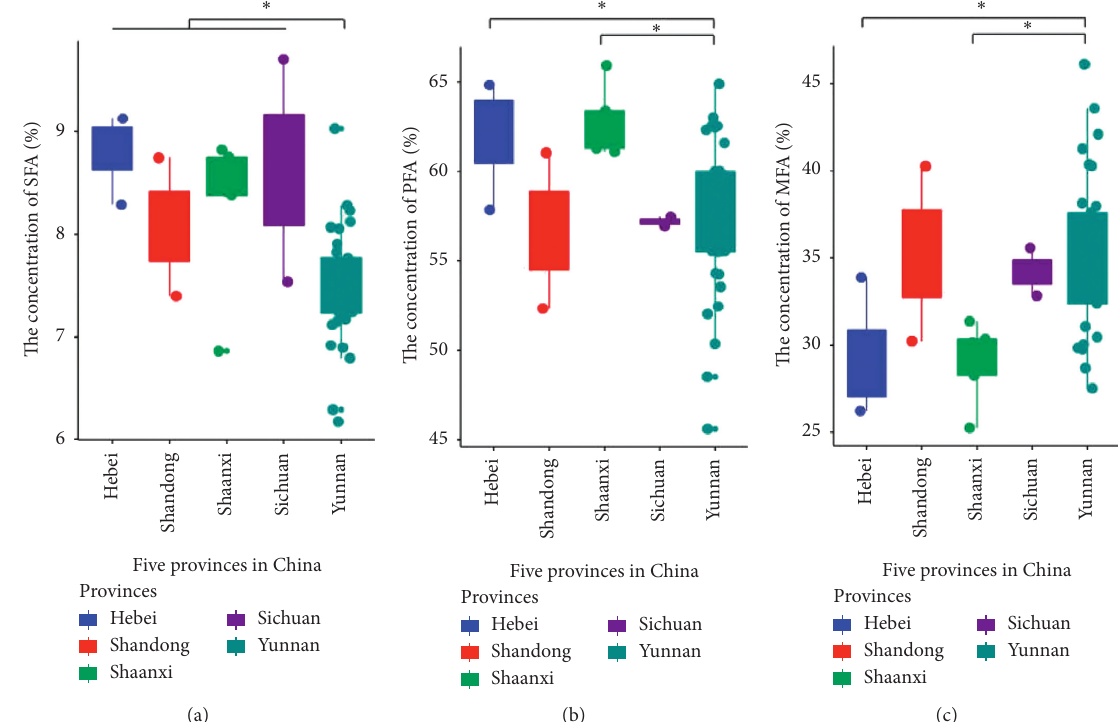
Figure 5: The (a) saturated fatty acid, (b) polyunsaturated fatty acids, and (c) monounsaturated fatty acid in 45 different types of walnut kernels from the main five walnut-planting provinces in China. Dunnett’s multiple-comparison tests were implemented for statistical analysis. Raw p value was labeled, ∗ p < 0 . 1 and ∗∗ p < 0 .